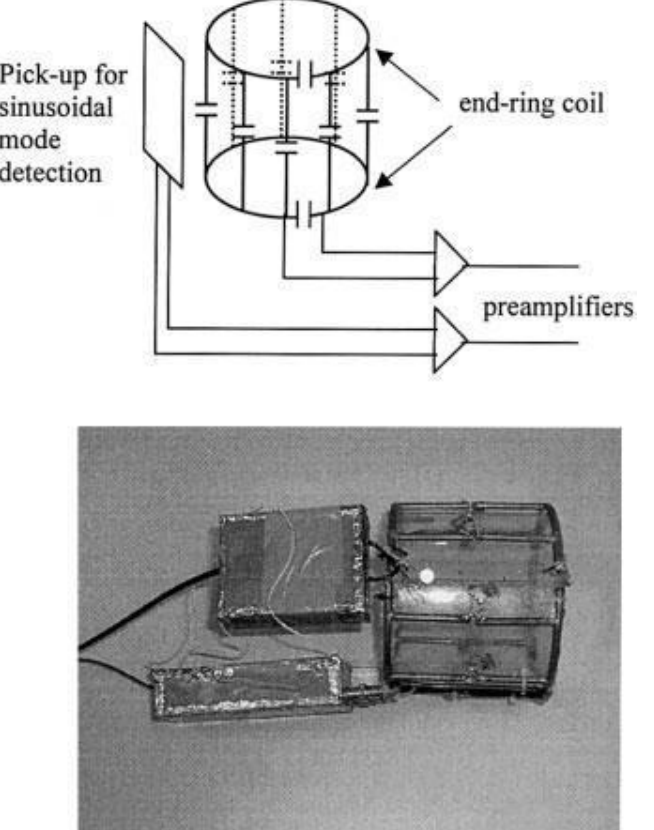
Figure 4. Representative sketch (top) and picture of the built quadrature coil (bottom). Reprinted from [35].